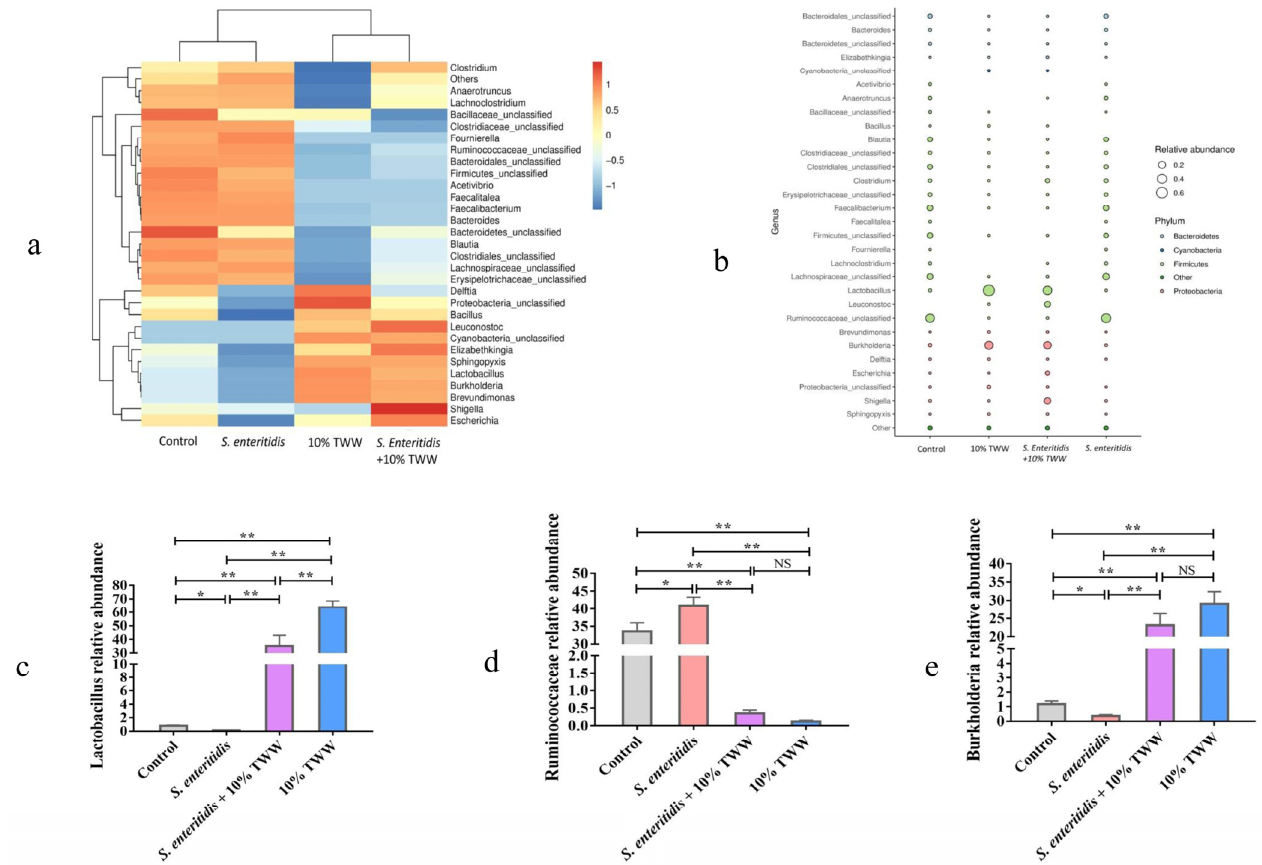
Figure 8. TWW alters the genus composition of gut microbiota in chickens. ( a ) Heatmap of a cluster of gut microbes in each group. ( b ) Bubble plot showing the relative abundance at the genus level. ( c – e ) Relative abundances of Lactobacillus , Ruminococcaceae , and Burkholderia . Values presented as means ± SEM. * p < 0.05, ** p < 0.01, compared between the indicated groups. NS: no significance between the indicated groups.